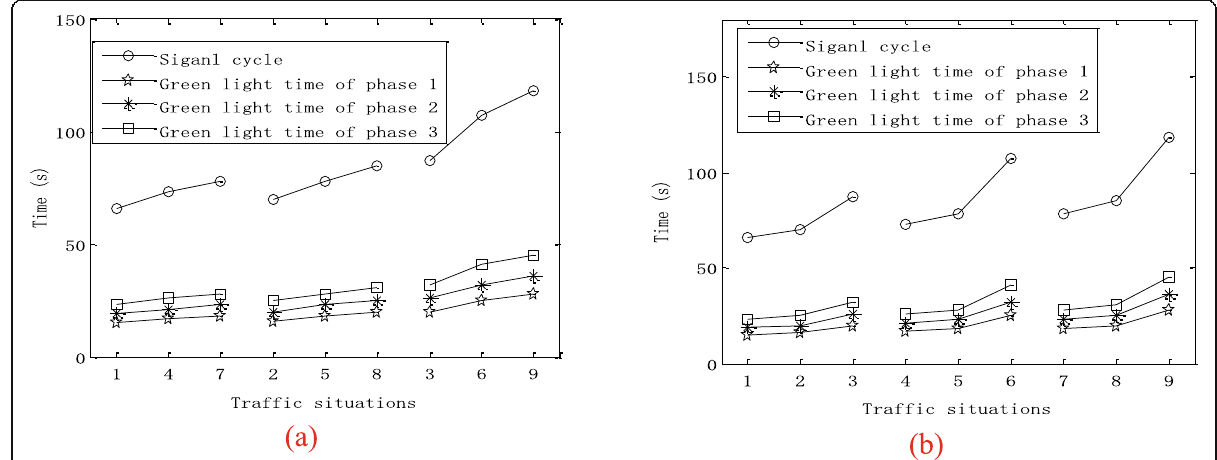
Fig. 2 Comparison of the timing results under different traffic situations. a Comparison of the timing results of different road section speeds with the same mixed proportion of electric vehicles. b Comparison of the timing results of different mixed proportions of electric vehicles with the same road section speed